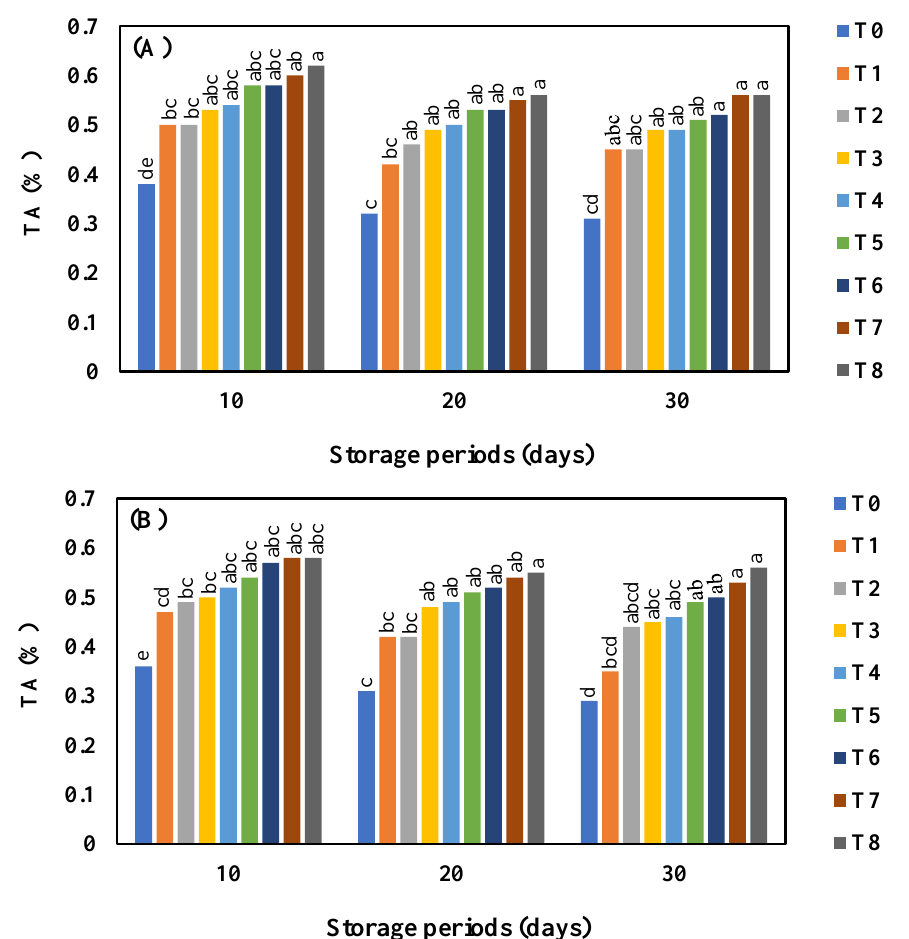
Figure 4. Effect of AgNO 3 and Ag-NPs on Titratable Acidity (%) in Shine Muscat ( A ) and Kyoho ( B ) grape varieties during 30 days cold storage.